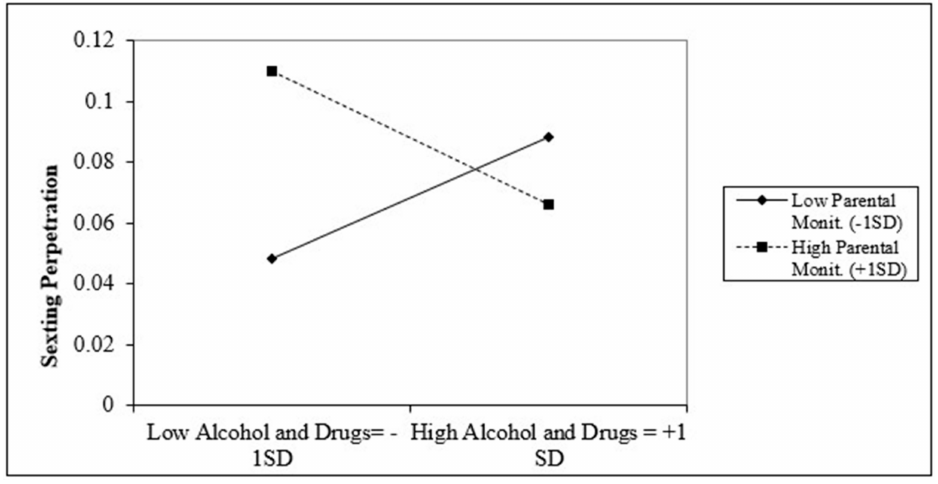
Figure 5. Interaction between alcohol and drug use and parental monitoring for LGB